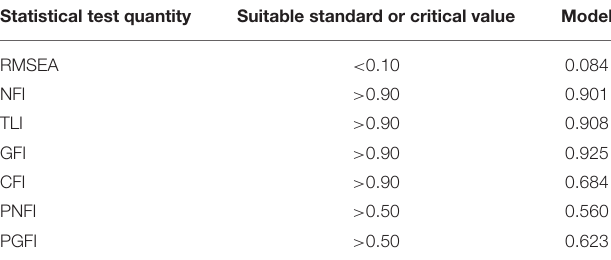
TABLE 11 | Model fitness factor test